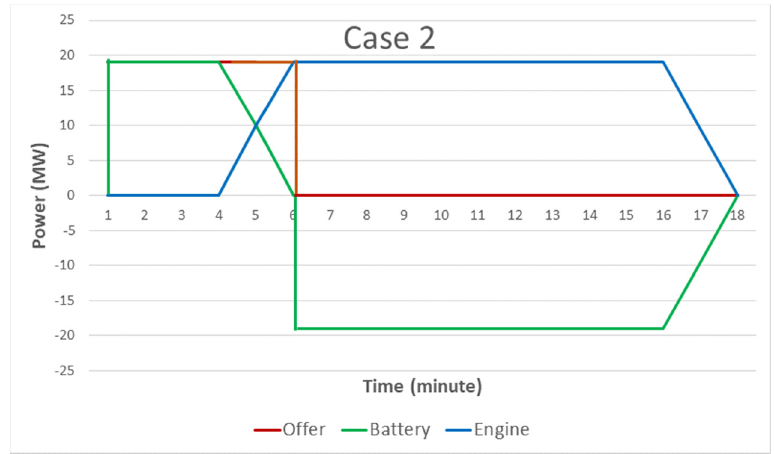
Figure 8. Example operation—case 2. Energies 2020 , 13 , x FOR PEER REVIEW